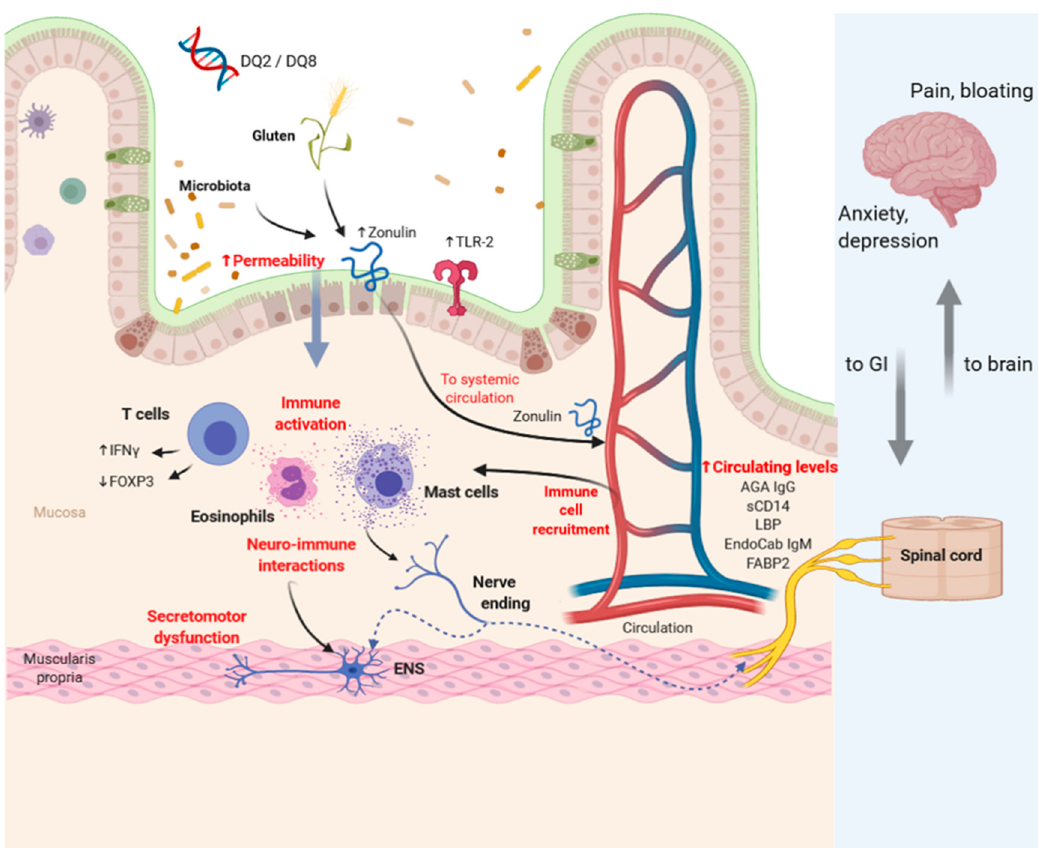
Figure 2. Representation of the potential mechanisms involved in the pathophysiology of non-celiac gluten sensitivity (NCGS). Based on the available data, the physiopathology of NCGS involves immune activation, permeability alteration, neuro-immune interactions, and genetic factors. Gluten and microbiota can increase epithelial permeability favoring the passage of different antigens into the mucosa and the consequent immune system activation. Neuro-immune activation and secretomotor dysfunction can likely (dashed lines) influence brain activity. TLR-2: Toll-like receptor-2; IFN- γ : interferon- γ ; FOXP3: forkhead box P3; AGA IgG: anti-gliadin antibody IgG; sCD14: soluble CD14; LBP: lipopolysaccharide-binding protein; EndoCab IgM: endotoxin core antibodies IgM; FABP2: fatty acid-binding protein2; ENS: enteric nervous system; GI: